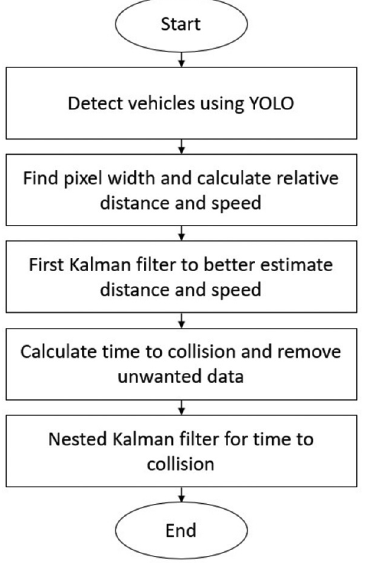
Figure 1 Nested Kalman fi lter